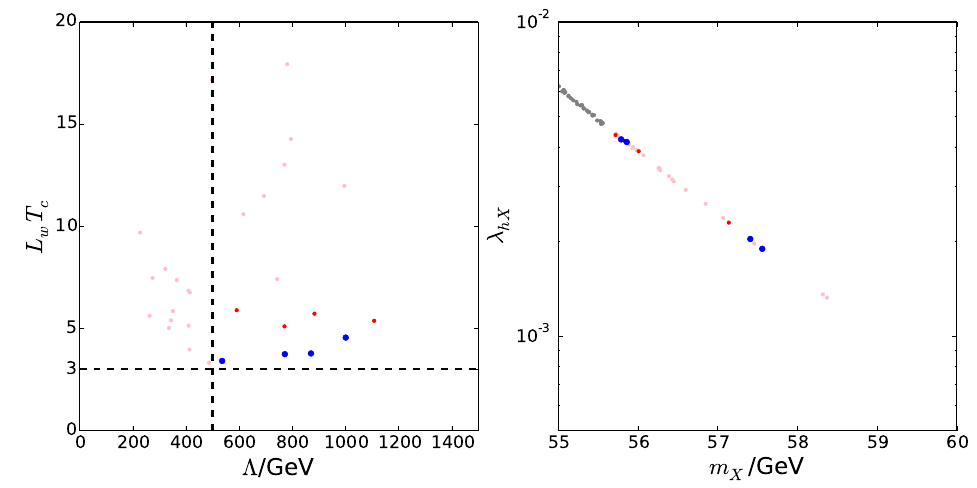
Figure 8 . Scatter plots of (cid:3) vs. L w T c (left) and m X vs. (cid:21) hX (right) according to the data obtained by the second scan. The pink, red and blue points represent models which can explain the DM relic abundance and the baryon asymmetry at the same time. The red and blue points are allowed by (cid:3) > 500 GeV and w 2 = (cid:3) 2 < 0 : 5 for the validity of the e(cid:11)ective operator O 6 , while c the pink points are excluded. The bigger blue points represent the benchmark models which can even satisfy w 2 = (cid:3) 2 < 0 : 2. The gray points on the right plot shows those which are ruled out by the c current DM direct detection upper